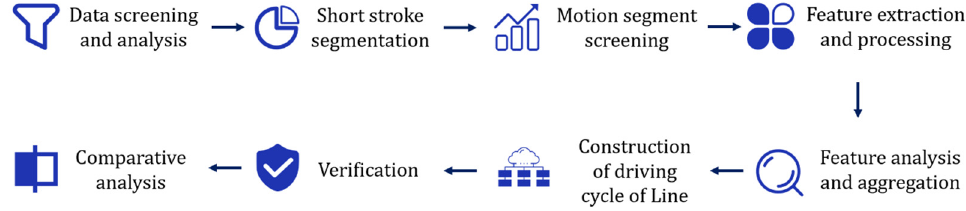
Figure 2. Transient driving cycle map construction process.